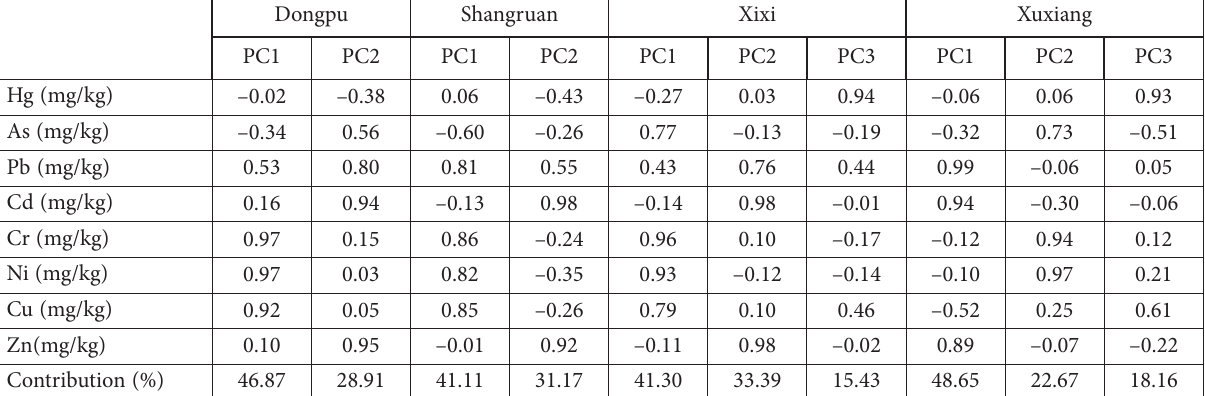
Table 7. Sources of soil heavy metal concentration in the different representative